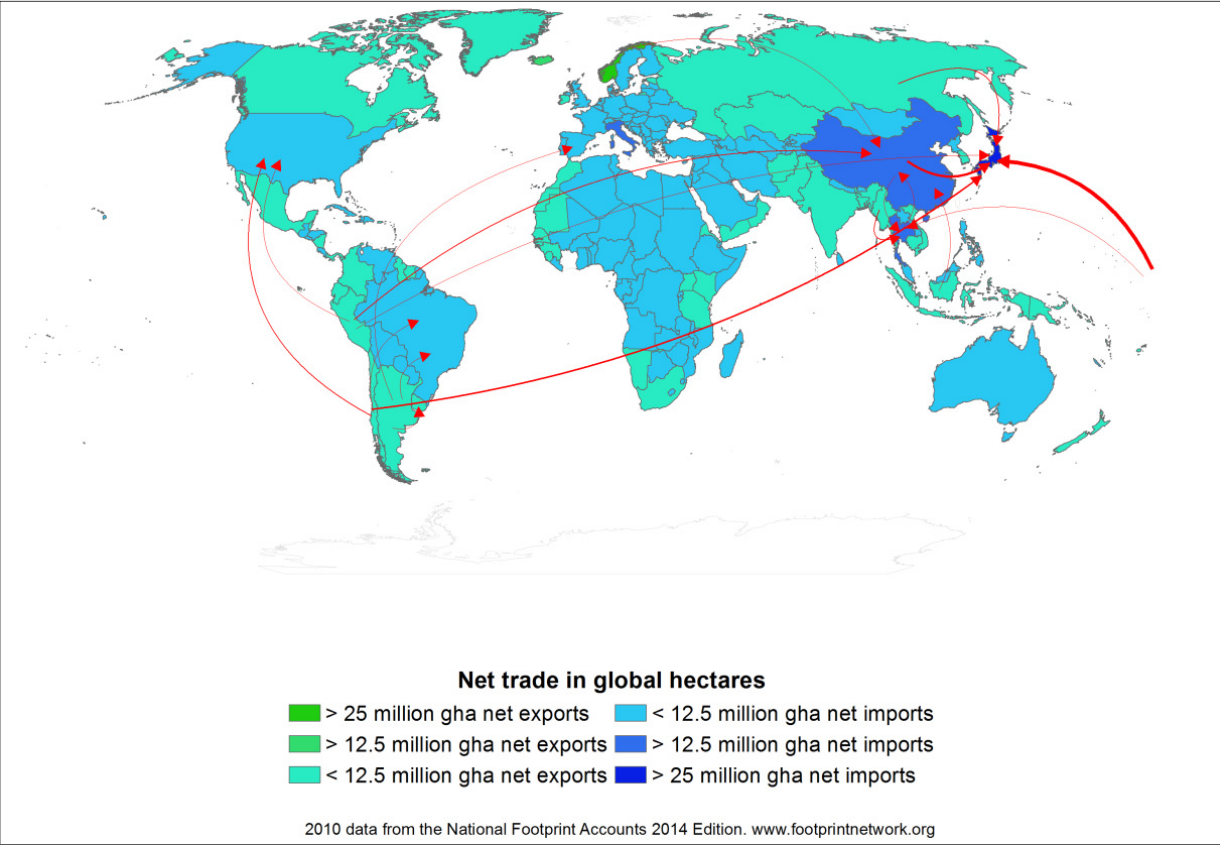
Figure 5. Net trade in fishing grounds biocapacity: arrows sized by magnitude of embodied biocapacity show the flows into the highest three net importers and out of the highest three net exporters (arrows from the Pacific are exports from a number of island nations